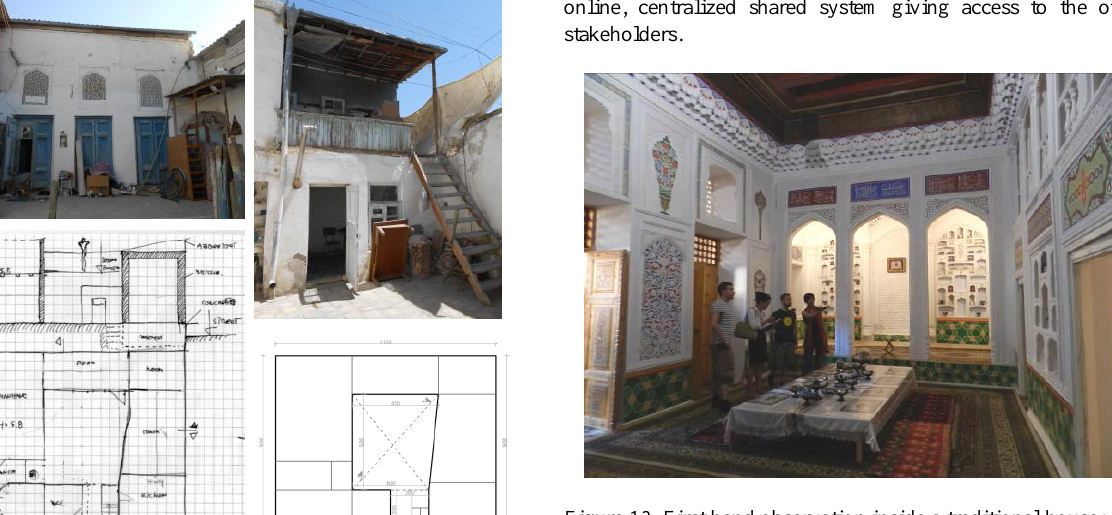
Figure 13. First hand observation inside a traditional house with